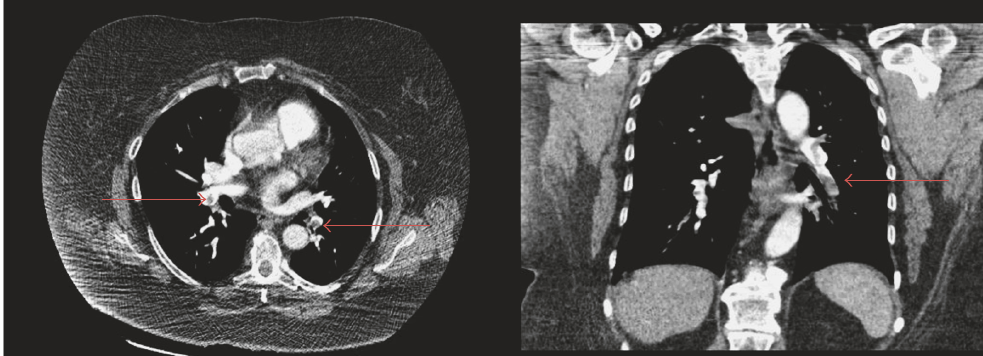
Figure 1: CT angiography showing bilateral pulmonary emboli (red arrows).